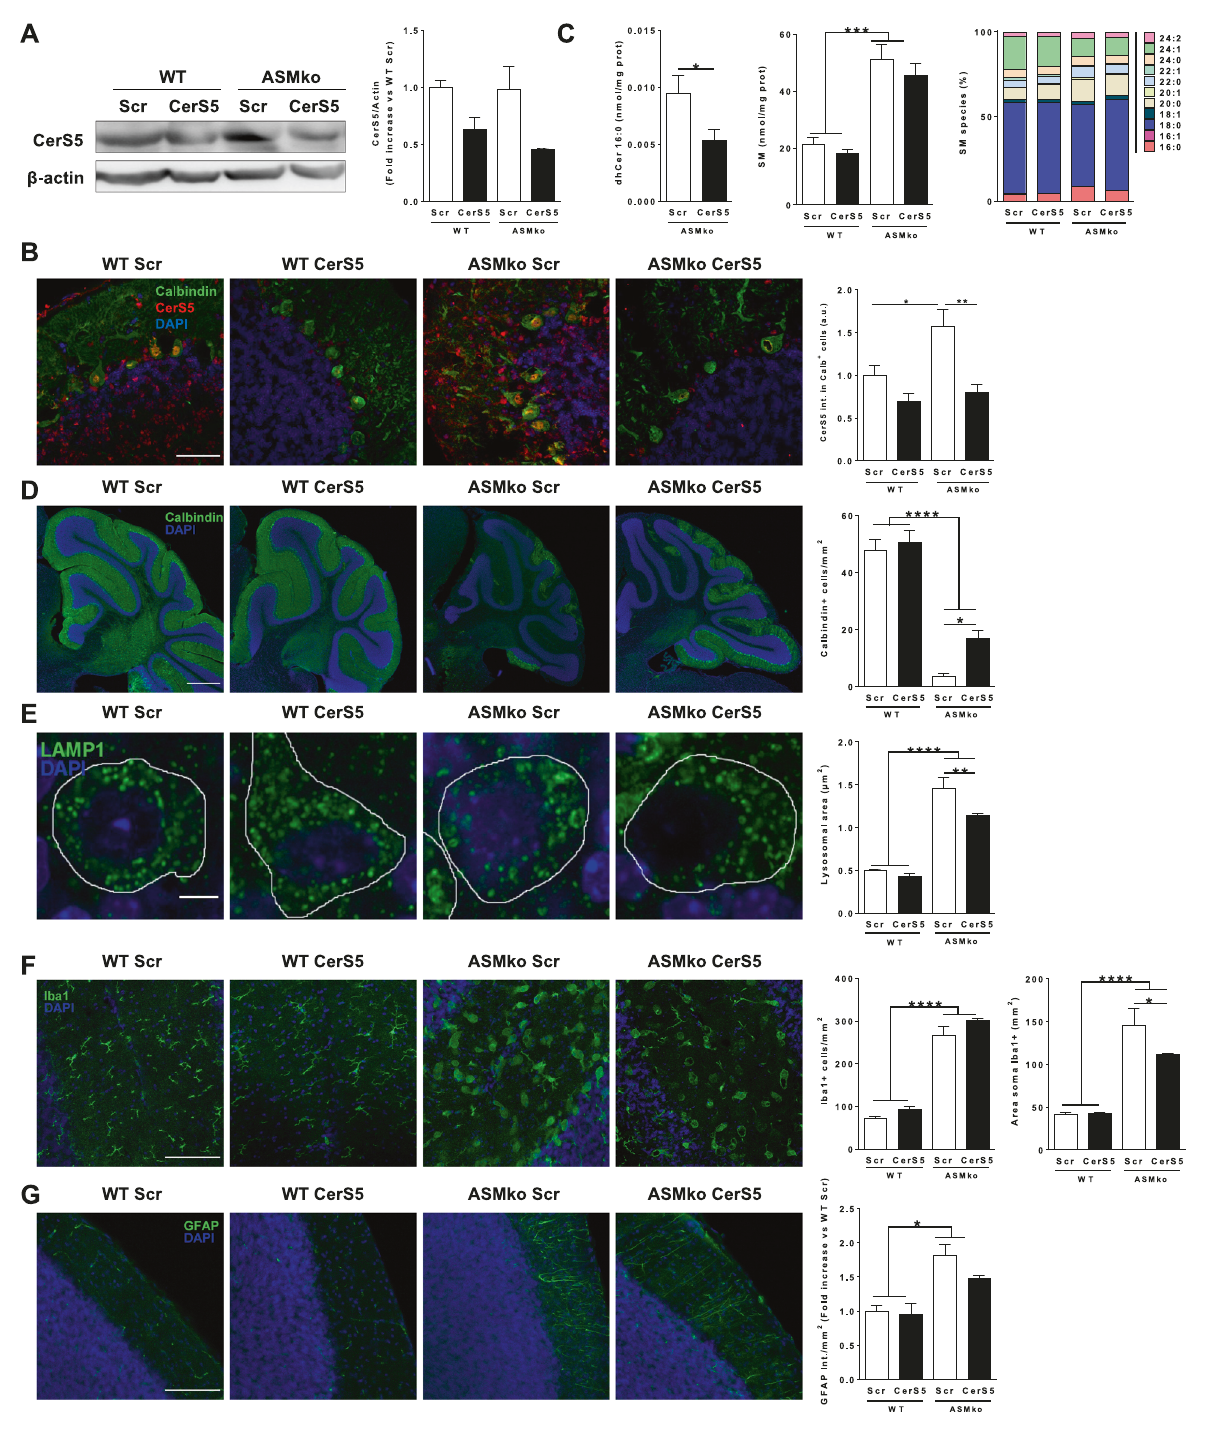
scramble injected ASMko mice as determined by immunohisto- chemical analysis with the speci fi c marker Calbindin (Fig. 6D). The lysosomal size was reduced by 1.3-fold in the Purkinje cells as assessed by immunohistochemical analysis against LAMP1 (Fig. 6E). In addition, we observed the reduction of microglia size, detected with the marker iba1 (1.3-fold) (Fig. 6F), and of astrocyte reactivity, detected with the marker GFAP (1.2-fold) (Fig. 6G) in the AAV9-shRNA-CerS5 injected compared to the AAV9- shRNA-